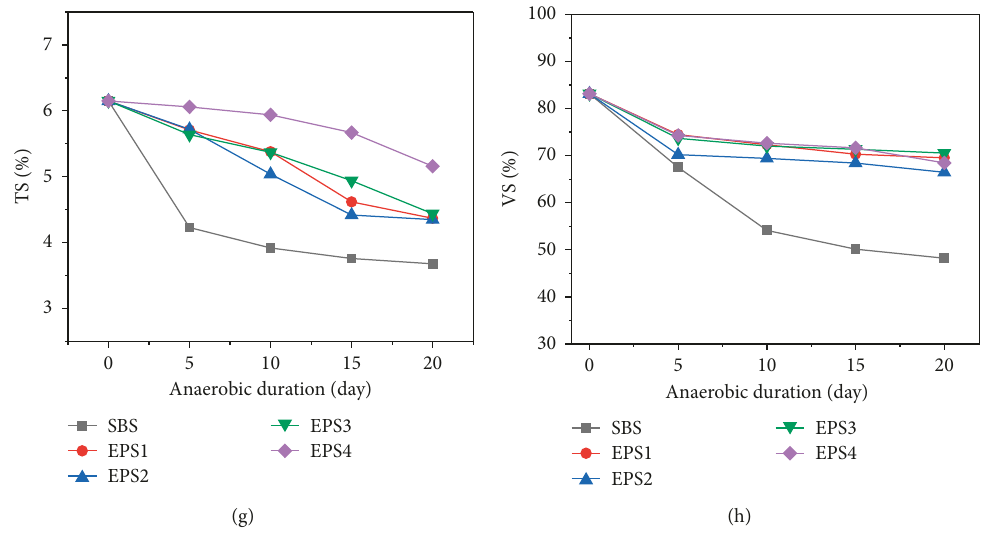
Figure 3: Total solids and volatile solid of samples. Table 2: TS and VS removal performance during digestion